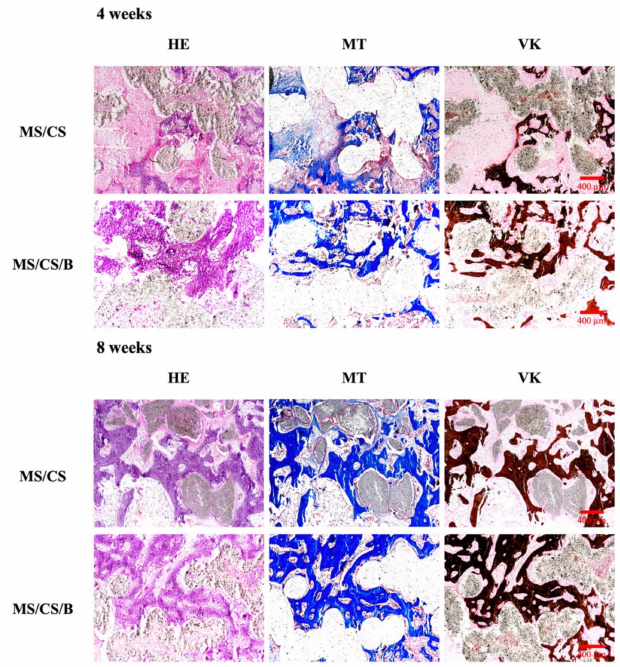
Figure 12. Histological analysis of new bone regeneration around and within the scaffolds in the rabbit femoral defect model. Left, hematoxylin and eosin (HE) stain; middle, Masson’s trichrome (MT) stain; and right, von Kossa (VK) stain of regenerated bone mass after 8 weeks of regeneration in the in vivo experiment. Purple: tissue morphology. Blue: collagen and bone matrix. Brown: bone mineralization. The scale bar of the histological photograph is 400 µ